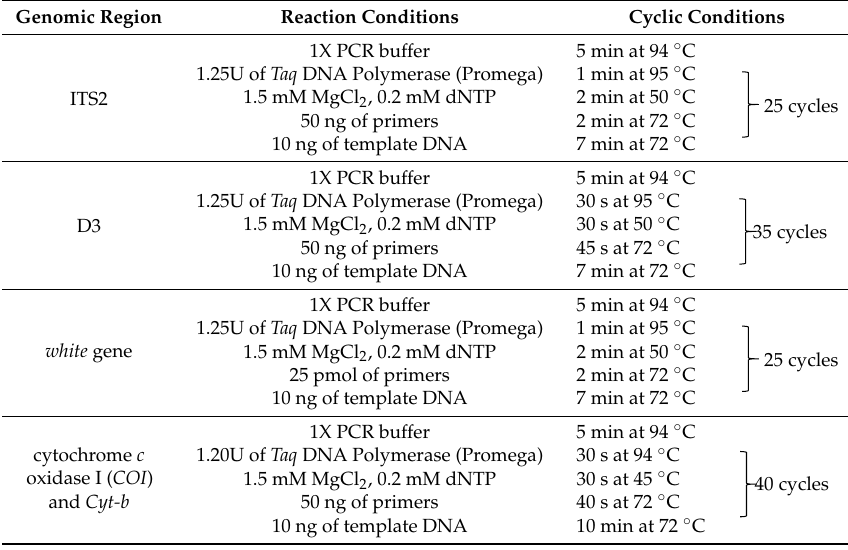
Table 2. Sibling species status of wild-caught female mosquitoes from sampling sites.